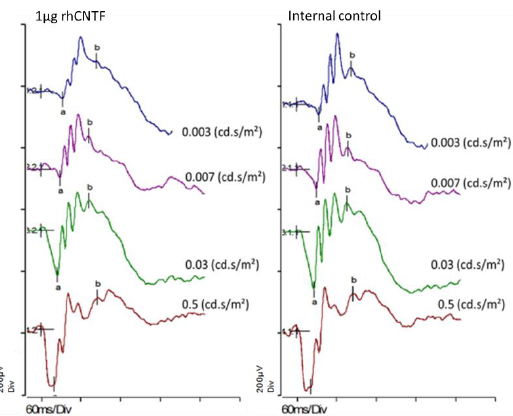
Figure 7. Scotopic Electroretinogram (ERG) recorded one week after 1 µg rhCNTF injection to the left eye. Equal visual acuity between the rhCNTF-treated eye and the contralateral untreated eye (internal control) was observed.